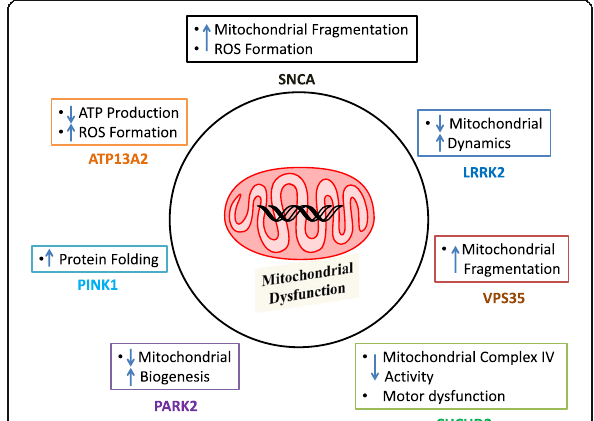
Fig. 1 Representative pathways of mitochondrial dysfunctions involved in Parkinson ’ s disease pathophysiology. SNCA: synuclein alpha; LRRK2: leucine rich repeat kinase 2; VPS35: vacuolar protein sorting-associated protein 35; CHCHD2: